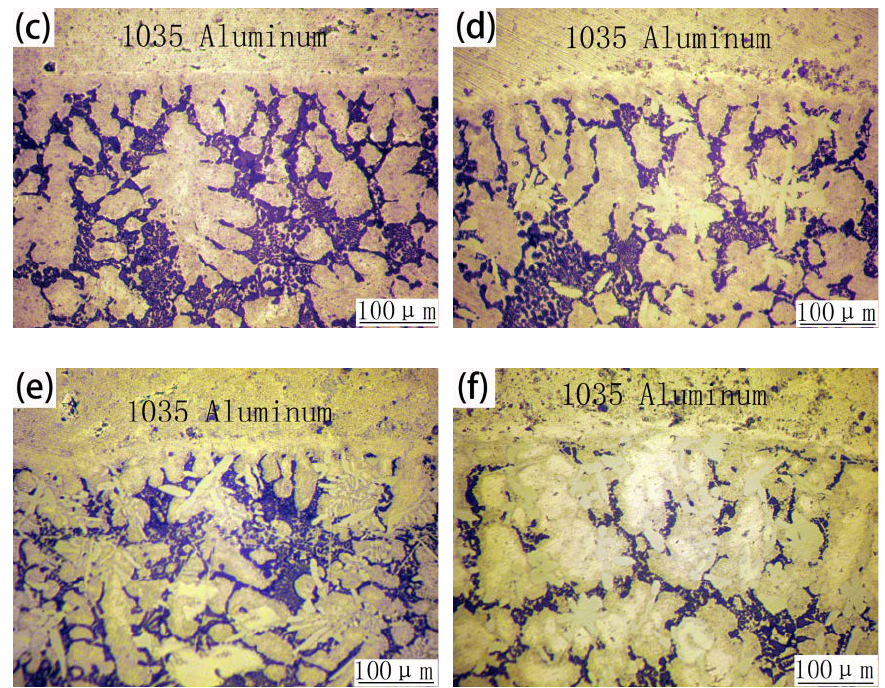
Figure 12. Microstructures of Al / brazing seam interfaces of 1035 Al / Cu joints brazed by ( a ) Zn-2Al; ( b ) Zn-5Al; ( c ) Zn-12Al; ( d ) Zn-15Al; ( e ) Zn-20Al; and ( f ) Zn-25Al.